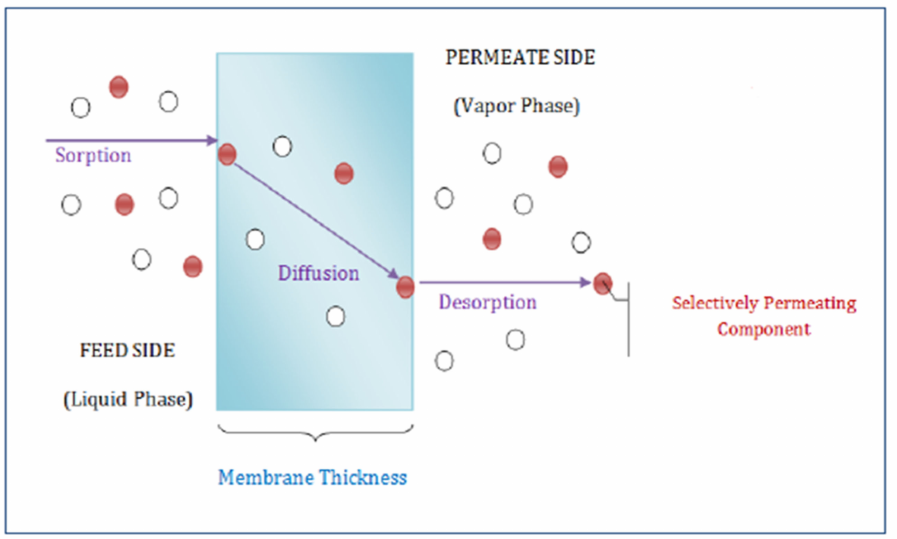
Figure 11. Comprehensive description of solution diffusion mechanism [96]. Adapted from